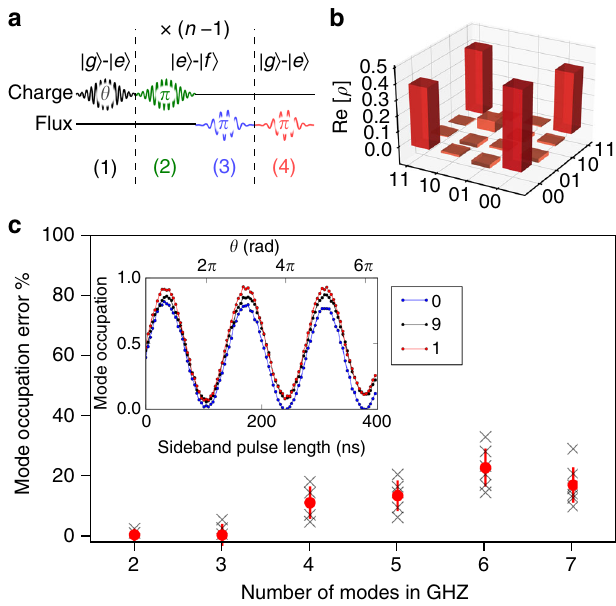
Fig. 5 Multimode entanglement. a Pulse sequence for generating n -mode maximally entangled states. Step (1) creates a superposition of the transmon g j i and e j i states, with the relative amplitudes of the superposition controlled by the rotation angle θ . Steps (2) and (3) load photons into modes of the memory, conditioned on the transmon state by utilizing the transmon f j i state. These steps are repeated n − 1 times to entangle additional modes. Step (4) performs a g j i (cid:2) e j i iSWAP to the last mode, disentangling the transmon from the modes. b The real part of the density matrix ( ρ ) of the Φ þ j i Bell state of mode 6 and 8, obtained from tomography. c (inset) Correlated oscillations resulting from sweeping θ and measuring each mode individually. This demonstrates control of the relative amplitudes of the entangled state superposition. c Deviation from expected mean populations of each of the modes, upon preparation of the GHZ state (cid:3) θ ¼ π . The red fi lled circles and error bars indicate the average and s.d., respectively, over individual mode measurements (black